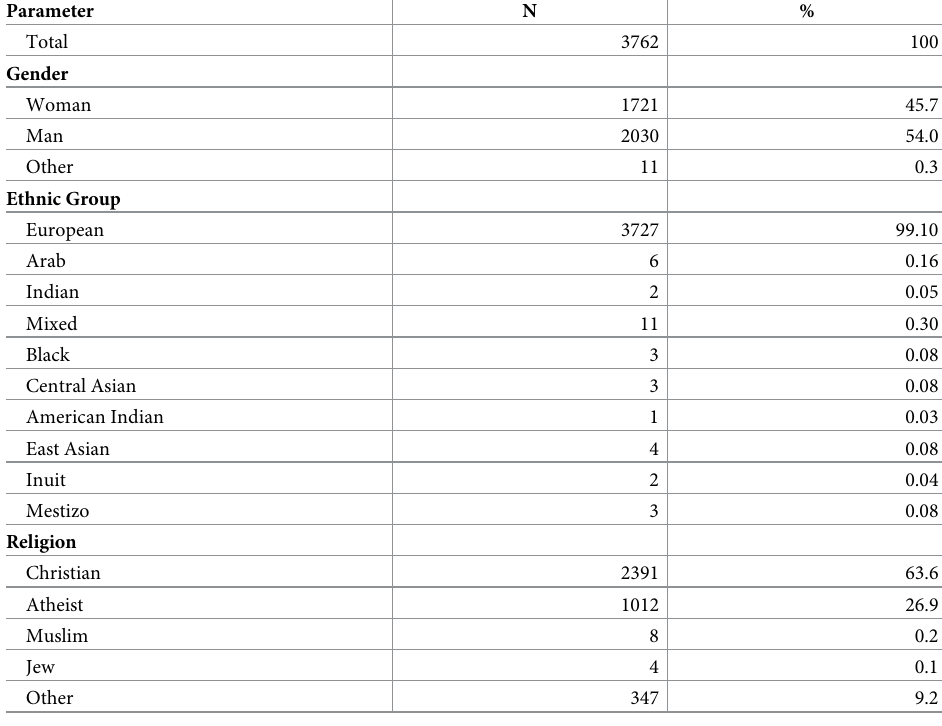
Table 1. Socio-demographic